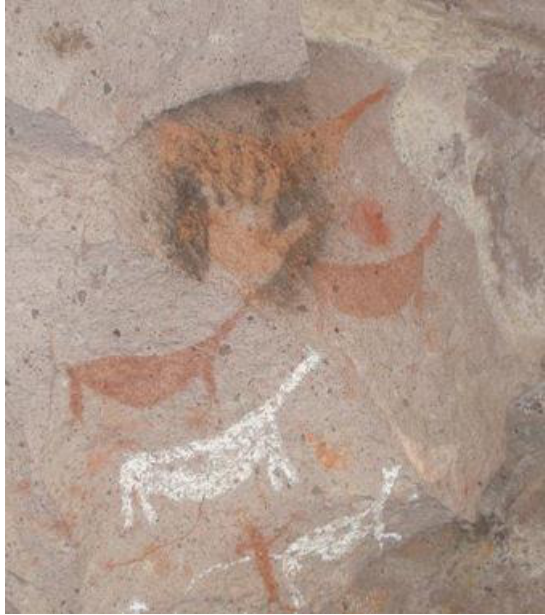
Figure 15. Superimposed hand, Charcamata, Santa Cruz, Argentina.